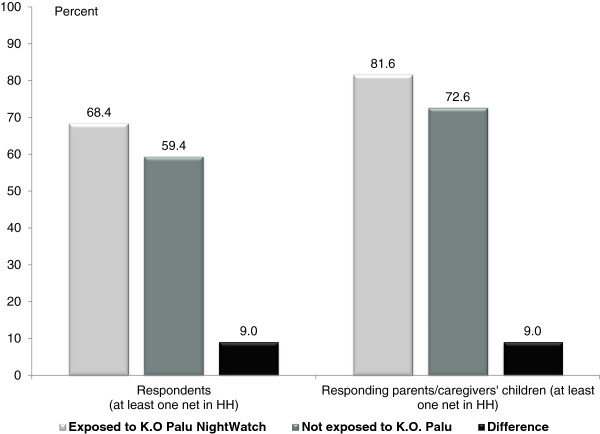
Marginal effects of KO Palu NightWatch on net use. Marginal effects of KO Palu NightWatch on last-night net use: results of logistic regression model with covariates held at mean values.